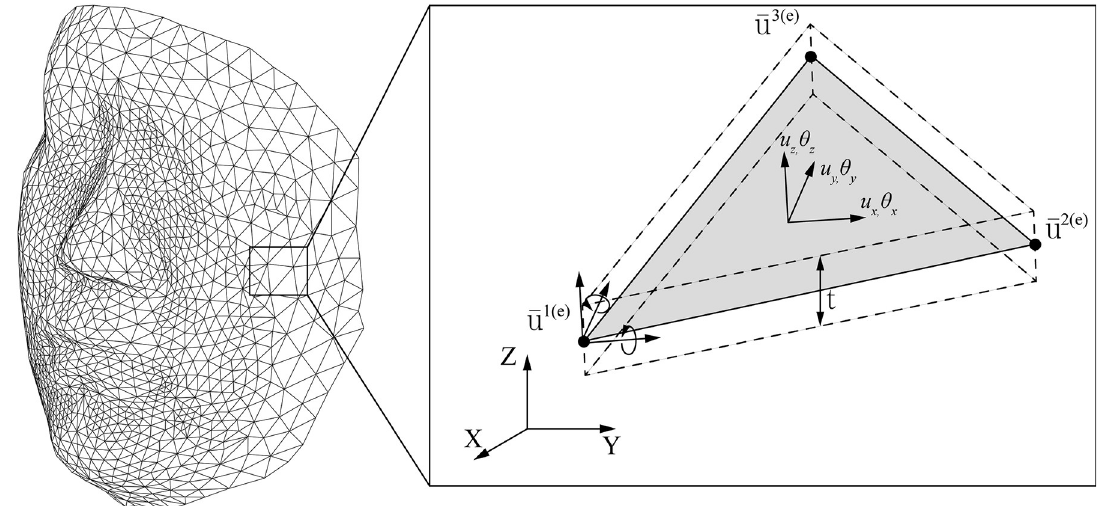
Fig 2. The template-registered face image concept of a single triangular shell